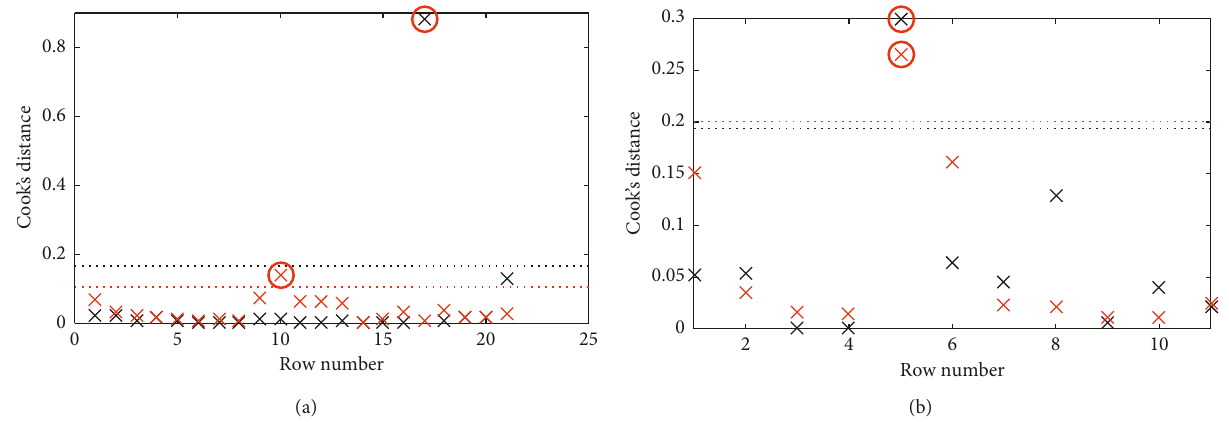
Figure 16: Distribution of the DSF values depending on the order of the MA